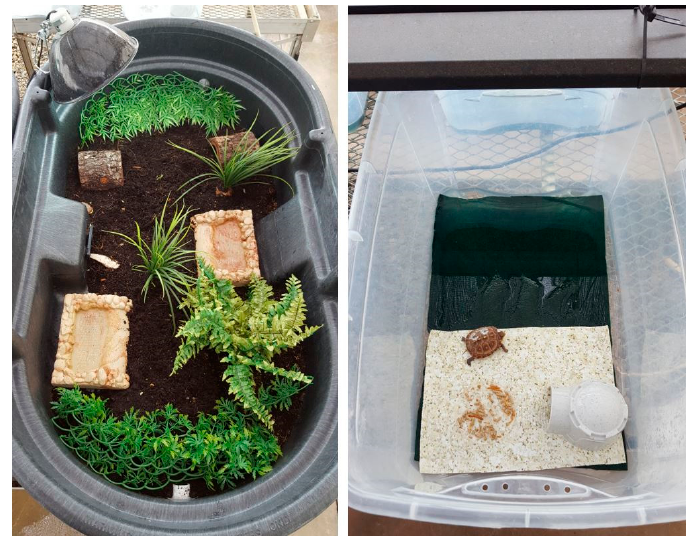
Figure 1. Rearing conditions for enriched ( left ) and unenriched ( right ) head-started eastern box turtles ( Terrapene carolina ). Enriched turtles were housed in groups of 4–5, provided with coconut fiber substrate to bury in, artificial plants and half logs for additional hiding areas, and naturalistic water dishes. Unenriched turtles were housed individually and provided with carpet for substrate and a small plastic hiding